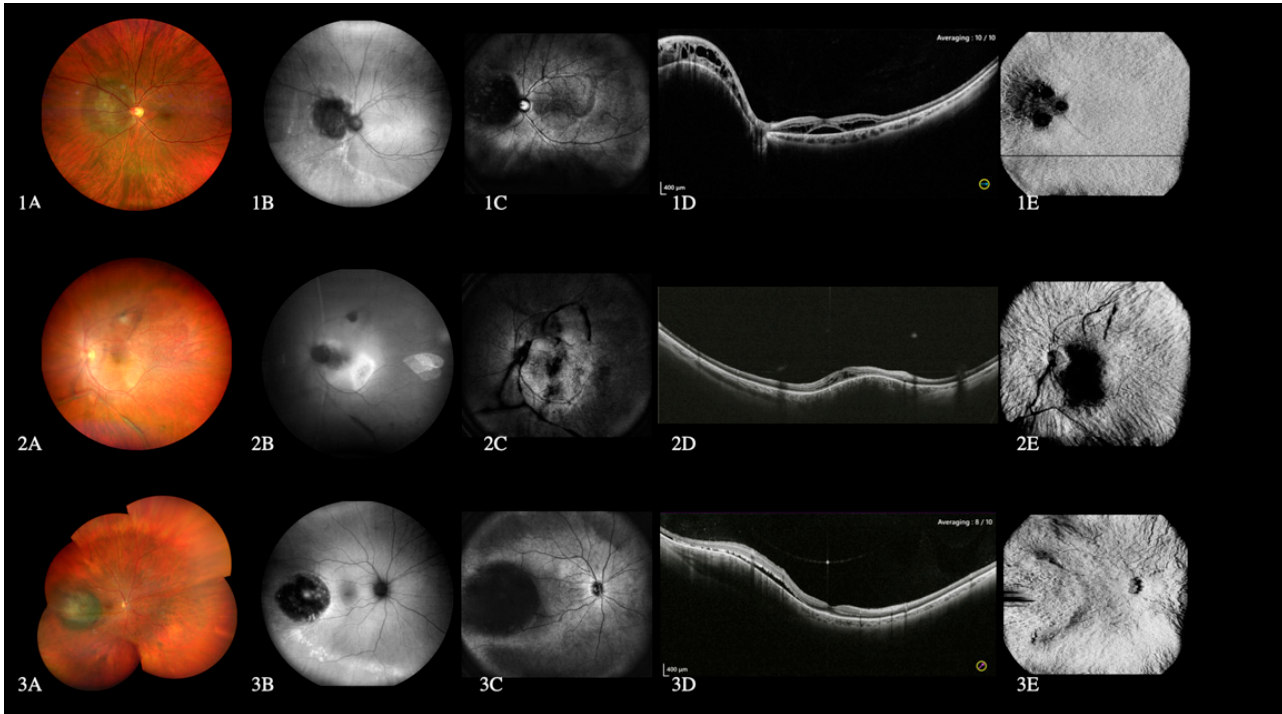
Figure 4. Images from left to right: color fundus retinography, green-autofluorescence, scanner laser ophthalmoscopy (SLO) image, wide-field optical coherence tomography (WF-OCT), and wide-field optical coherence tomography angiography (WF-OCTA). Choroidal hemangioma adjacent to the optic nerve is shown at the top ( 1A – 1E ), choroidal granuloma secondary to tuberculosis in the middle ( 2A – 2E ), and choroidal melanoma at the bottom ( 3A – 3E ). A dark image on the SLO is observed in hemangioma ( 1C ) and melanoma ( 3C ). WF-OCT shows intraretinal and subretinal fluid in the hemangioma ( 1D ), intraretinal fluid in the granuloma ( 2D ) and subretinal fluid in the melanoma ( 3D ). Vascularization can be seen on the WF-OCTA in the hemangioma ( 1E ) and melanoma ( 3E ) but not in the granuloma ( 2E ).